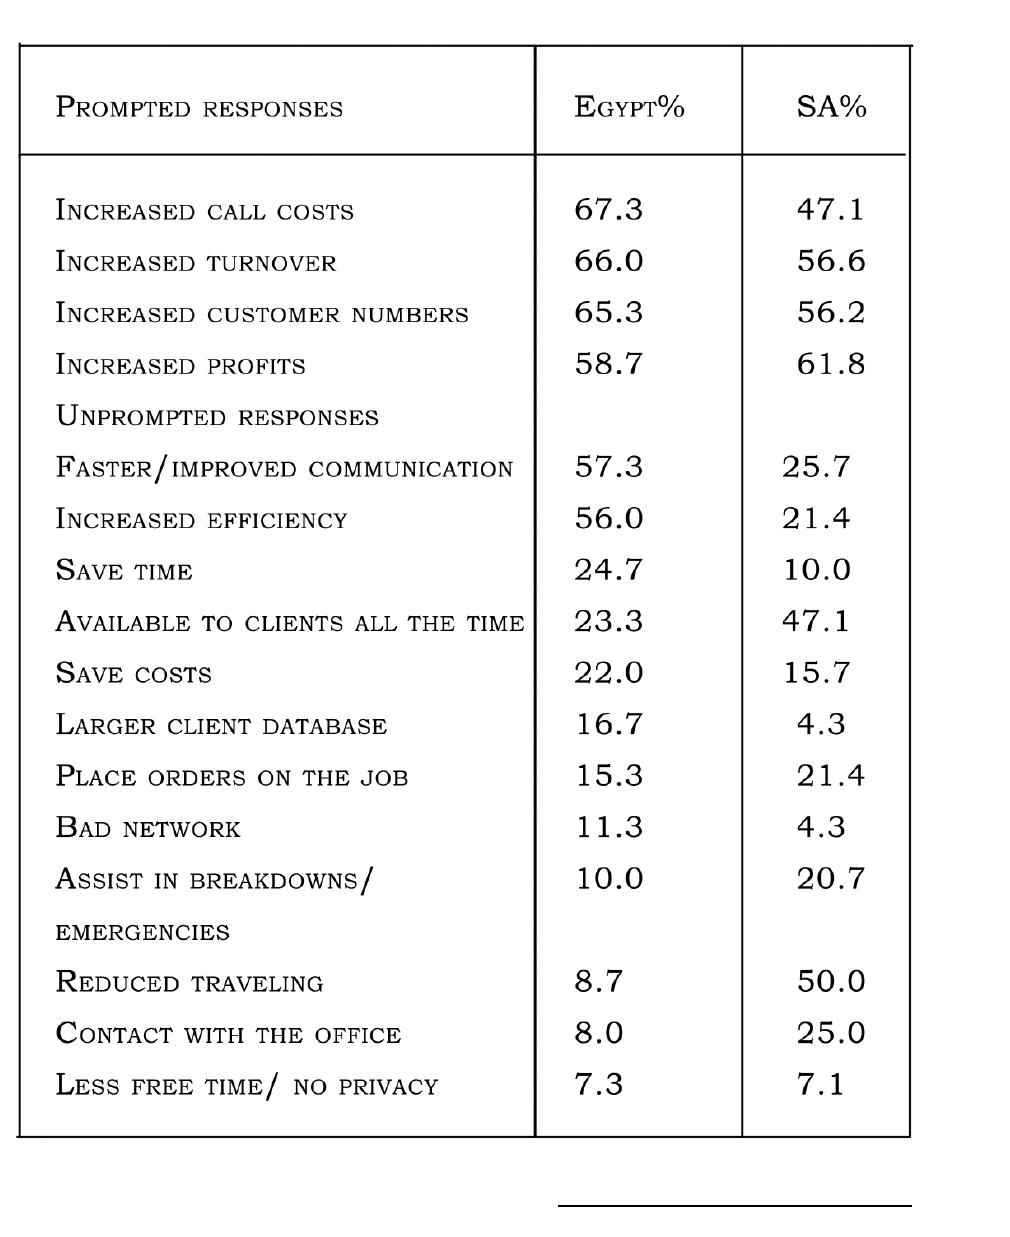
Table 3. Impact of mobile phones on small businesses